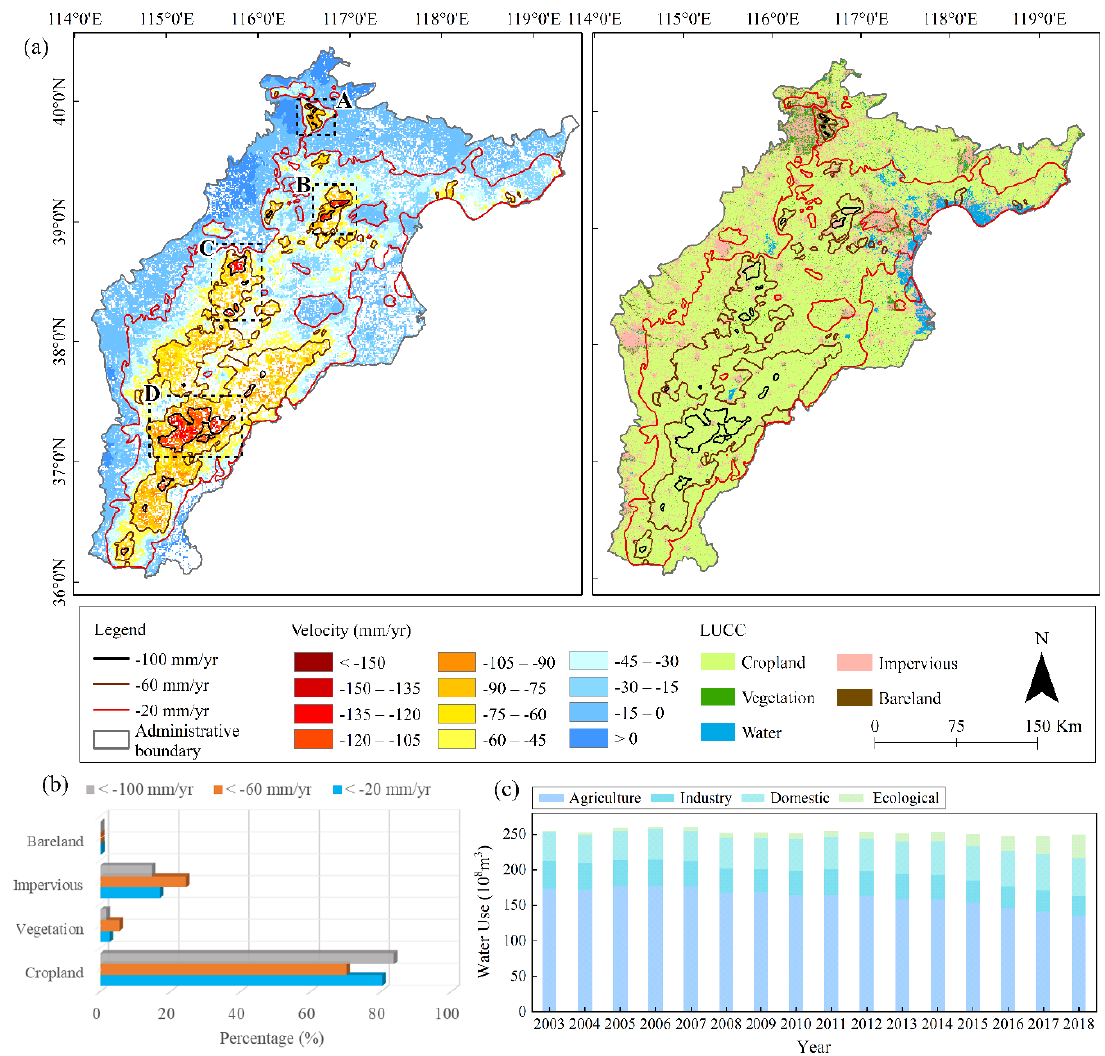
Figure 10. ( a ) Contour map of the 40-mm interval superimposed onto the vertical displacement across the study area in the left panel and onto the classification of land use types in the right panel and ( b ) statistics of land use types within different ranges of subsidence contours.